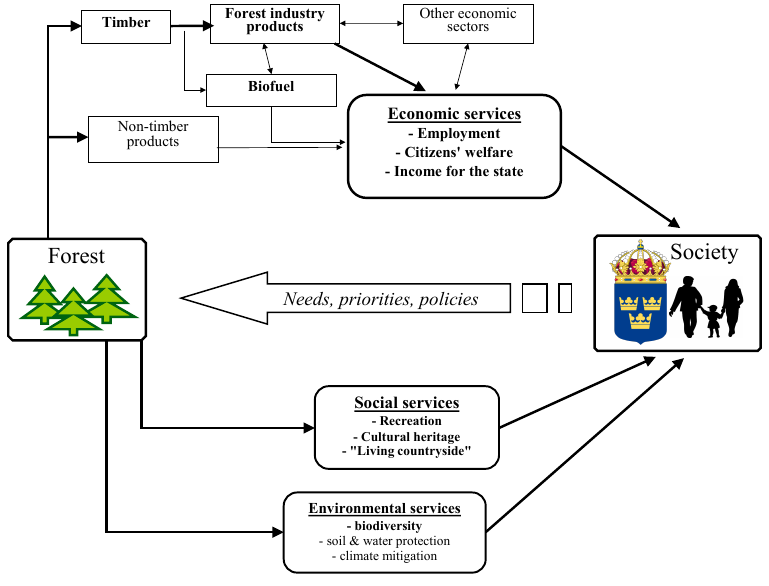
Figure 1. Macro perspective (forest sector) in